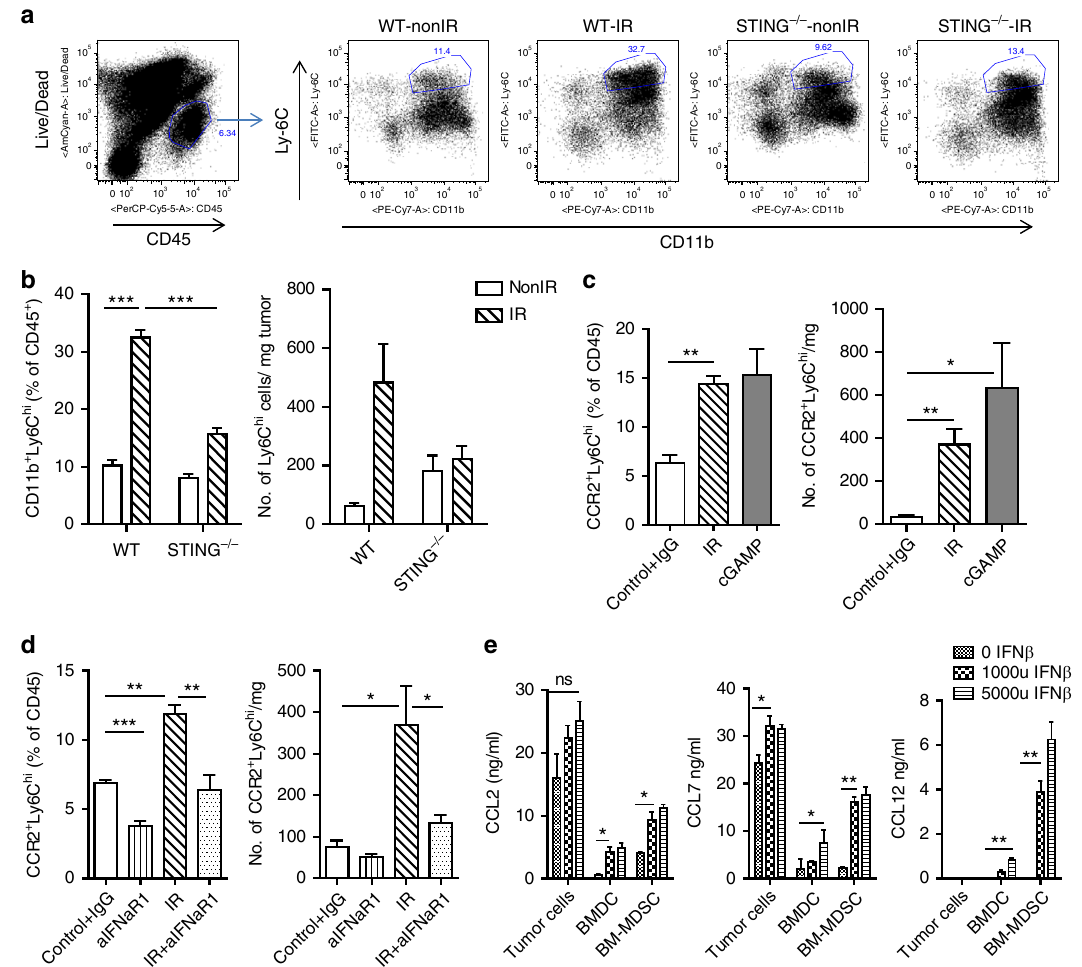
Fig. 5 Monocytic MDSCs mobilization is dependent on STING and type I IFN signaling after irradiation. a Representative fl ow gating chart. b Quanti fi cation of Ly6c hi population in tumors in WT and STING − / − mice. c Activation of STING pathway by IR or by cGAMP administration can increase the recruitment of CCR2 + Ly6c hi cells. d Quanti fi cation of the CCR2 + Ly6c hi population in tumors grown in WT control, IR and IR + anti-IFNaR1 treated mice. e Type I IFN induces expression of CCL2 and CCL7 in tumor cells and CCL12 in host cells ( n = 4); * P < 0.05; ** P < 0.01; *** P < 0.001. Each experiment was repeated four times. Data are presented as mean ± anti-CCR2 antibody, and 20 Gy + anti-CCR2 antibody (Fig. 3d and Supplementary Fig. 1C). Of note, treatment with the anti- CCR2 monoclonal antibody (mAb) clone MC21 alone decreased